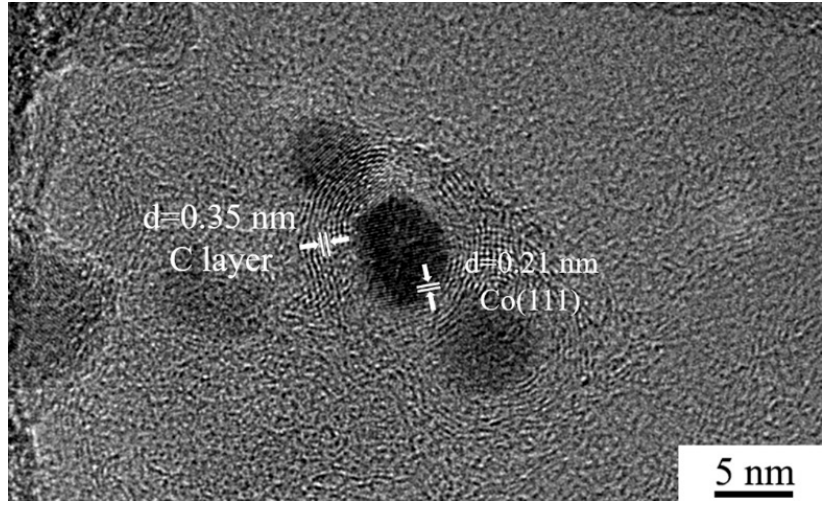
Figure 2. The HR-TEM image of CNC.